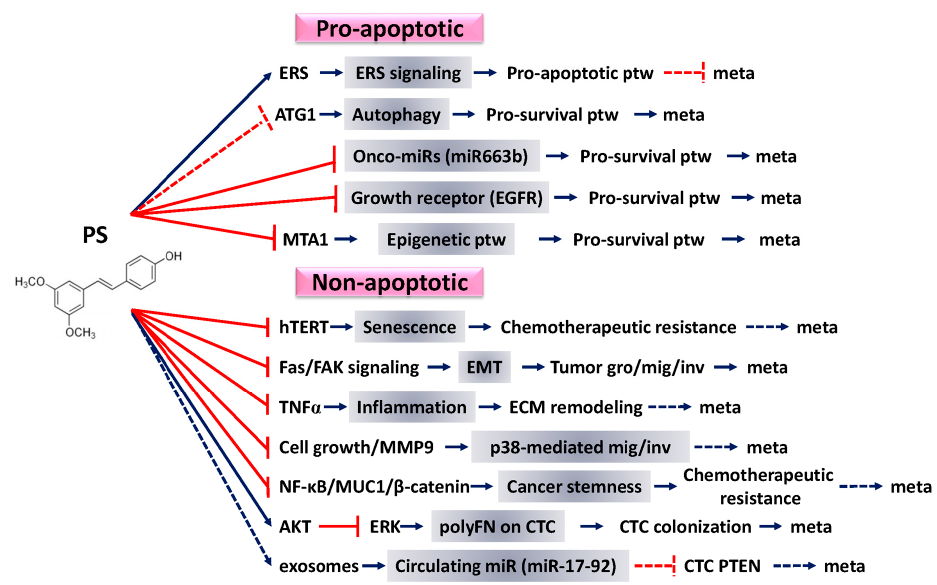
Figure 2. The overview of anticancer properties of pterostilbene ( trans -3,5-dimethoxy-4-hydroxystilbene; PS). PS are able to target apoptosis-dependent and -independent signaling pathways against cancer progression and likely cancer metastasis. The key events affected by PS in all the pathways are boxed in grey color. In the category of pro-apoptotic effects, PS inhibits onco-miRs (e.g., miR663b) and growth factors (e.g., EGFR), triggers an epigenetic modification through the inhibition of MTA1, induces ERS, or lowers autophagy through the inhibition of ATG1. In the category of nonapoptotic effects, most of the effects caused by PS are shown to inhibit pro-tumor signaling pathways including hTERT, Fas/FAK signaling, TNF α , cell growth/MMP-9, NF- κ B/MUC1/ β -catenin, AKT/ERK signaling axis, and packed in circulating sEVs that are involved in senescence prevention, EMT, inflammation, p38/mediated migration/invasion, and cancer stemness, polyFN assembly on CTCs, and miR17-92-delivery in the circulation, respectively. All these apoptosis-dependent and -independent inhibitory effects caused by PS likely lead to a reduction of cancer metastasis. Note: signaling events involved in the anti-metastatic activities of PS are depicted as solid or broken lines whenever supported or not yet supported (only logically deduced), respectively, by the literature. The corresponding full names abbreviated are listed as follows: ptw, pathway; meta, metastasis; gro, growth; mig, migration; inv,